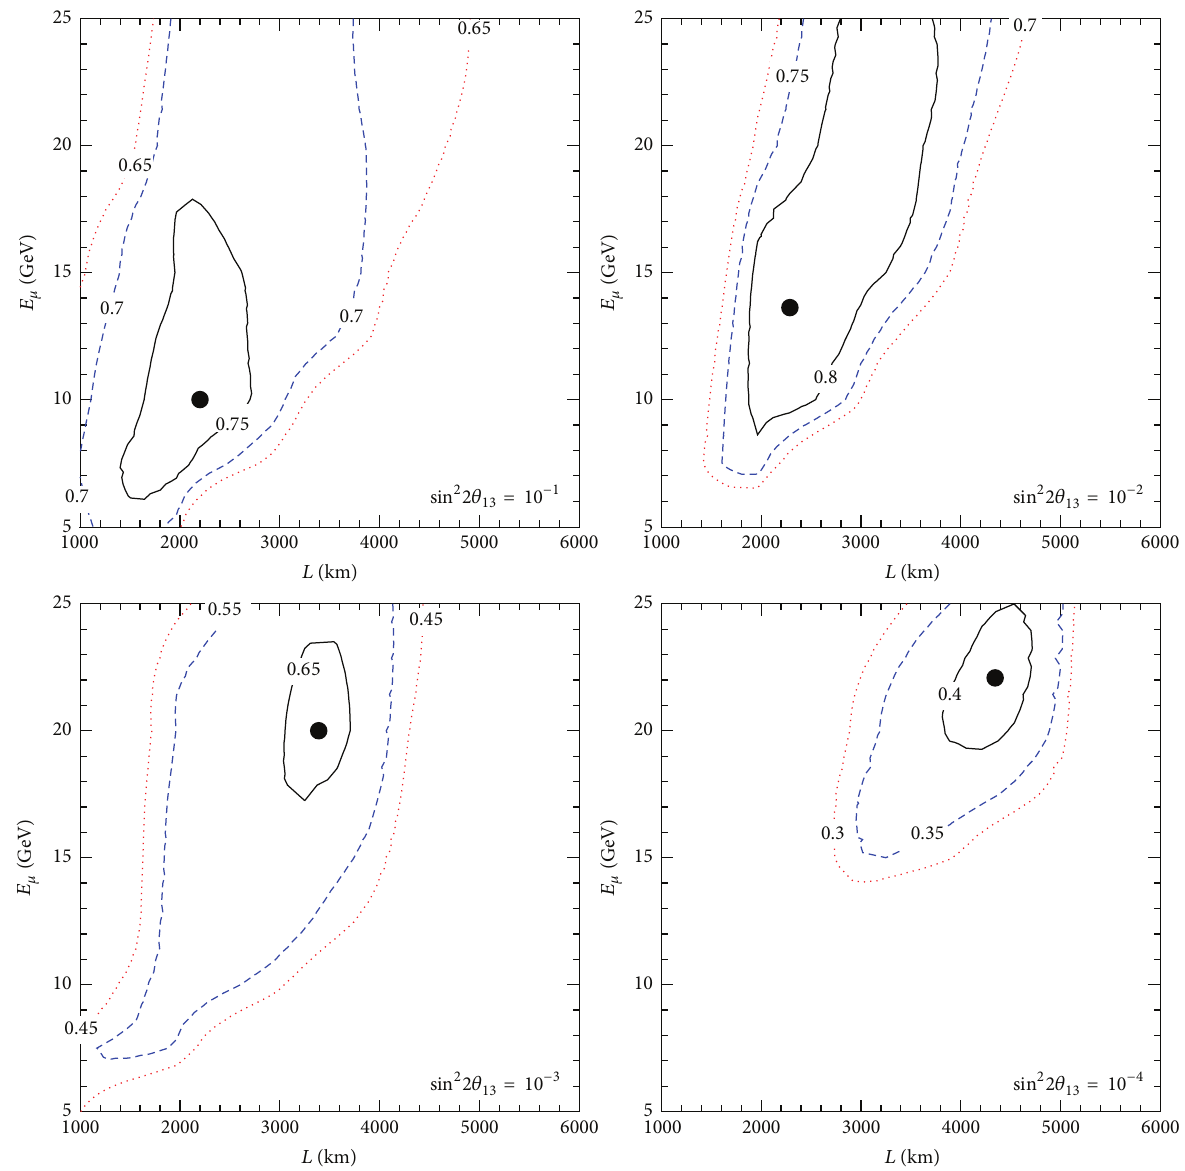
Figure 17: Fraction of 𝛿 (true) for which CP violation will be discovered at 3𝜎 CL as a function of 𝐿 and 𝐸 𝜇 for the single-baseline Neutrino CP Factory. The different panels correspond to different true values of sin 2 2𝜃 13 , as given there. Here, we consider 5 × 10 21 useful muon decays in total with a 50 kilotons MIND detector. The optimal performance is marked by a dot: (2200, 10.00), (2288, 13.62), (3390, 20.00), and (4345, (true) at 0.77, 0.84, 0.67, and 0.42. This figure has been taken from 22.08) with regard to their best reaches of the fraction of 𝛿 CP